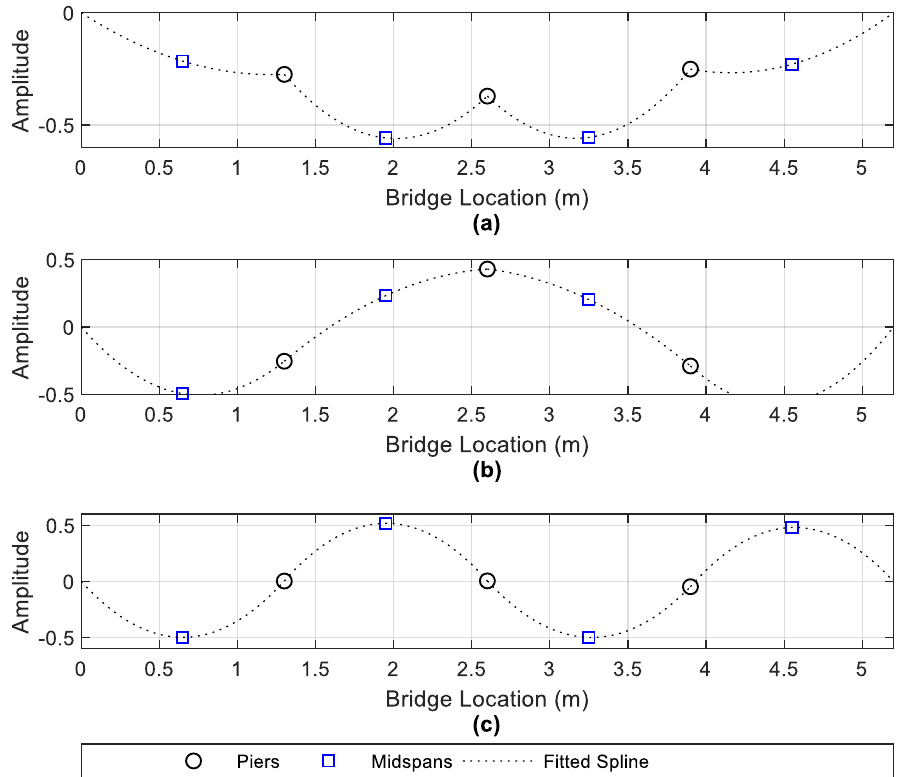
Figure 11. FDD frequency picking procedure.